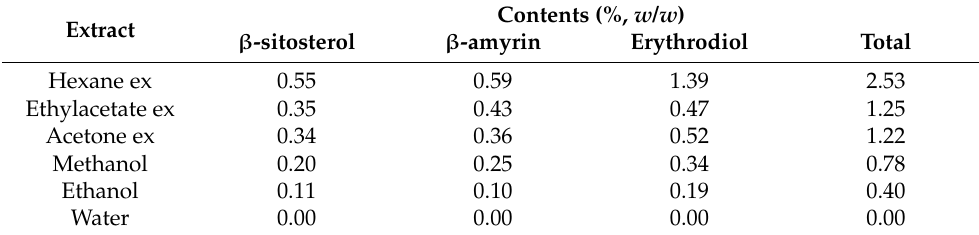
Table 3. Contents of β -sitosterol, β -amyrin, and erythrodiol in IW leaf extract.